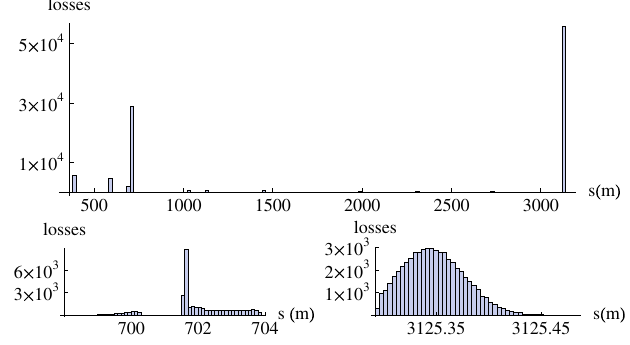
FIG. 15. (Color) The distribution of 206 Pb 82 þ losses after IP2. The two bottom plots show zooms on the largest peaks on the upper plot. Only the loss at s (cid:2) 3125 m risks to induce quenches, because of the small projected spot size.